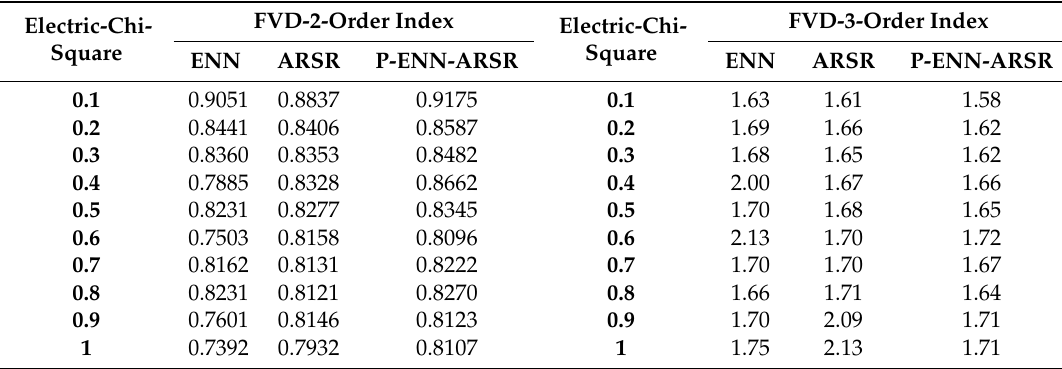
Table 9. FVD-2-order and FVD-3-order index